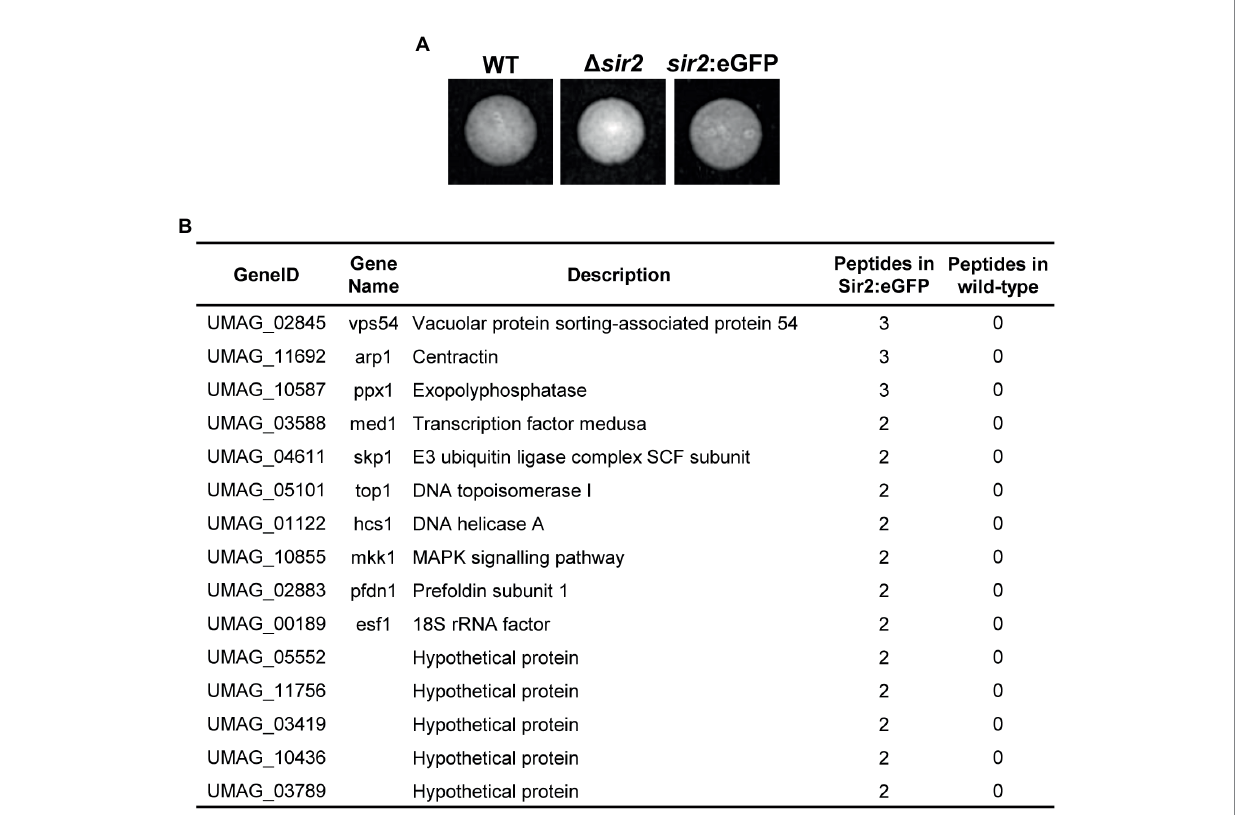
FIGURE 7 Sir2 interacting proteins. (A) Sir2 fussed to eGFP does not affect its function. Images showing the filamentation of wild-type, and the indicated mutants on PD-charcoal plates for 18 h at 25 ° C. (B) Proteins interacting with Sir2. Identified proteins by Sir2 immunoprecipitation followed by mass spectrometry analysis. Proteins with log2 > 6 and, at least, 2 peptide in all replicates of the sir2:eGFP mutant and none in the wild-type are